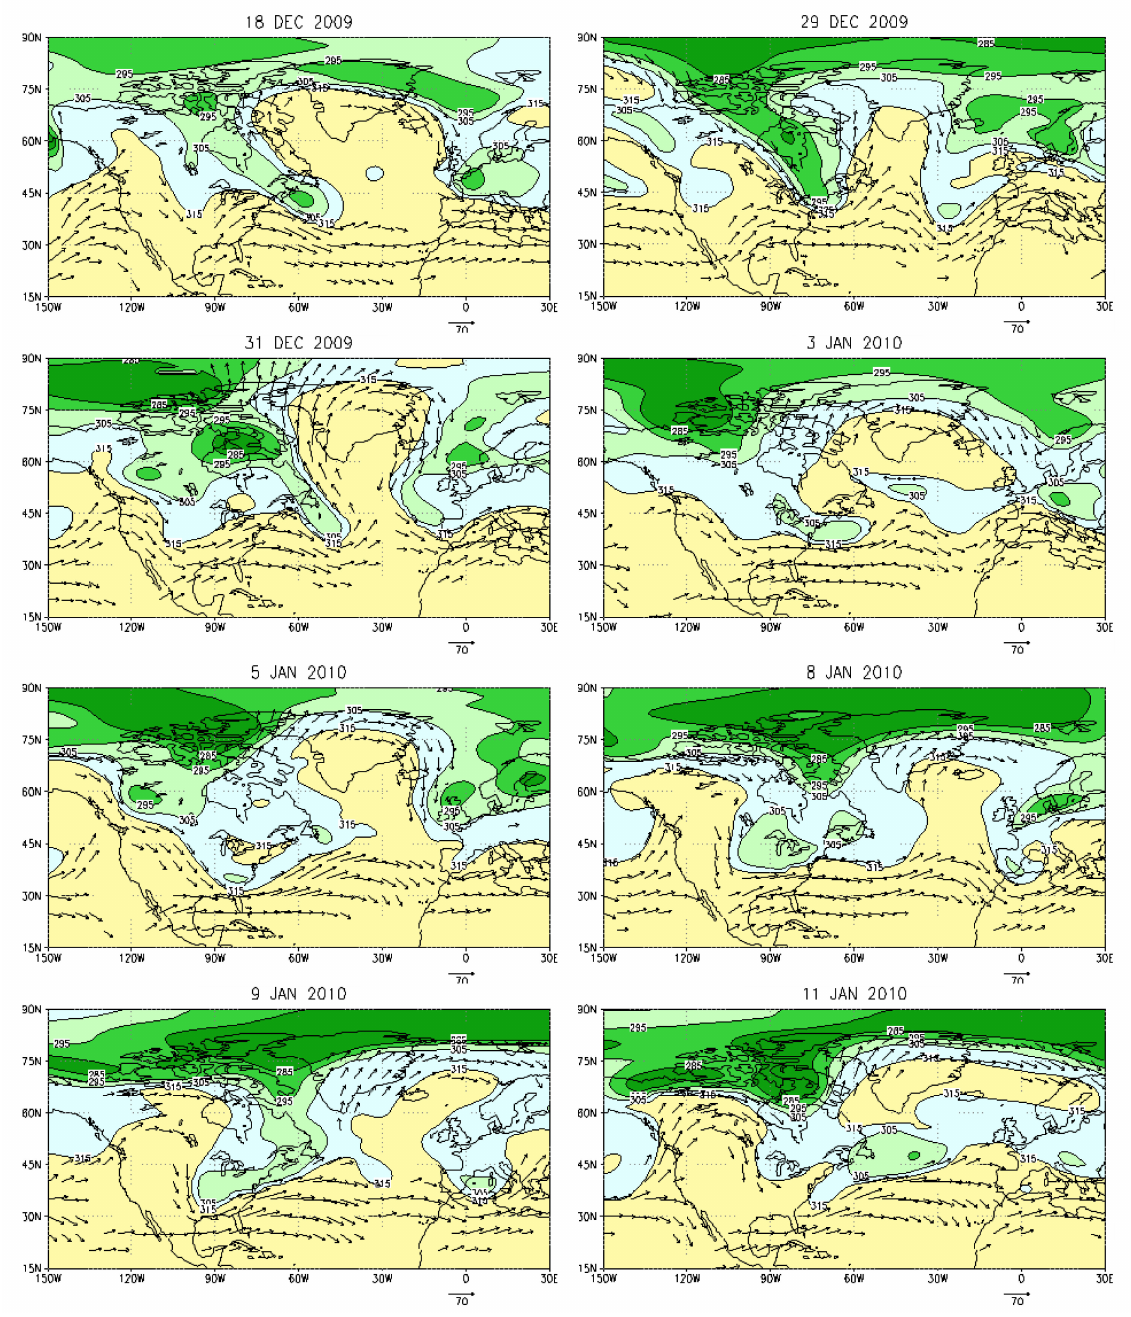
Figure 4. Unfiltered θ fields on the 2-PVU surface for the negative NAO event from 24 December 2009, to 13 January 2010 ( θ , shaded, unit: K; the wind, vectors, unit: m · s − 1 ; the corresponding date is marked on the top of each